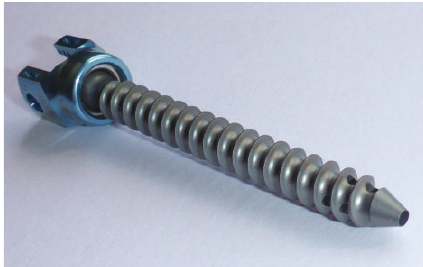
Figure 1: Polyaxial cannulated and fenestrated screw. The screw is fully cannulated with a total of six distal fenestrations (four fenestrations are in sight). Note the polyaxial screw